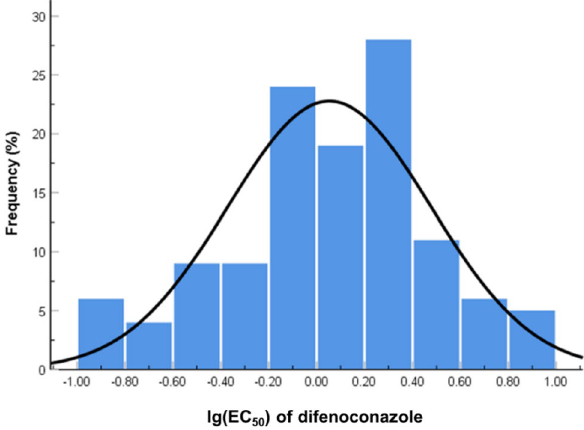
Figure 1. Frequency distribution of lg (EC 50 ) values of difenoconazole against 121 Lasiodiplodia theobromae isolates when the outliers were excluded.